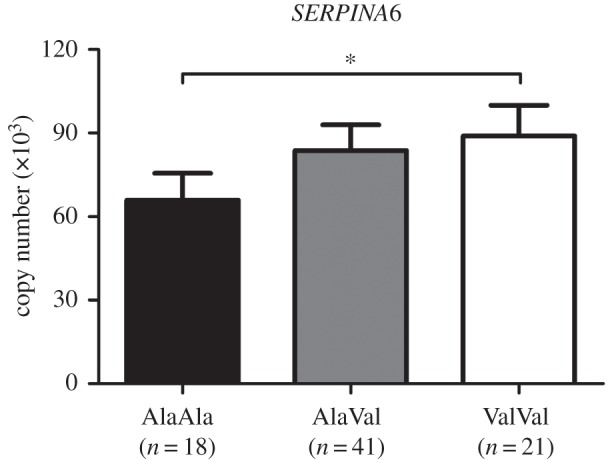
Effect of the GRAla610Val substitution on expression of SERPINA6, which encodes corticosteroid-binding globulin, in liver of peripubertal pigs. SERPINA6 expression was measured using quantitative real time PCR. Data are presented as least-squares means ± s.e. *p < 0.05.